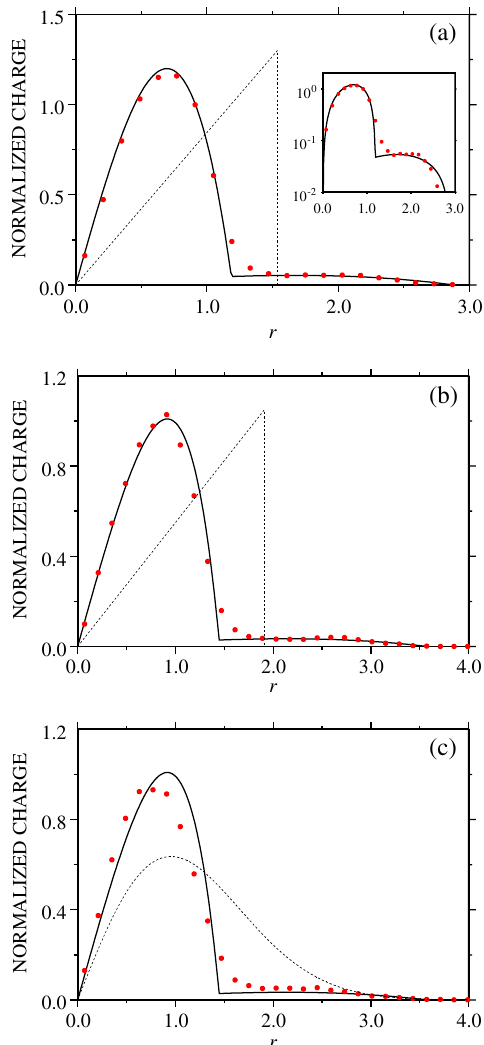
FIG. 2. Comparison of the normalized charge as a function of radius obtained from the theory (solid curve) and the N -particle simulation (red dots). The space-charge parameter and the initial (cid:5) ¼ 0 : 1 and waterbag in (a), distributions considered are: K=k 0 0 (cid:5) (cid:5) K=k ¼ 1 : 0 and waterbag in (b), and K=k ¼ 1 : 0 and fully 0 0 0 0 Gaussian in (c). In all the cases, (cid:6) ¼ 1 : 5 , r is measured in units =k Þ 1 = 2 , and the charge is normalized to the total charge N of ð (cid:5) 0 0 in the beam. For the sake of comparison, we also present the respective initial normalized charge distributions (dashed curves). The inset in (a) presents the normalized charge in log form, showing that despite the large difference in core and halo density, the theory agrees well with the